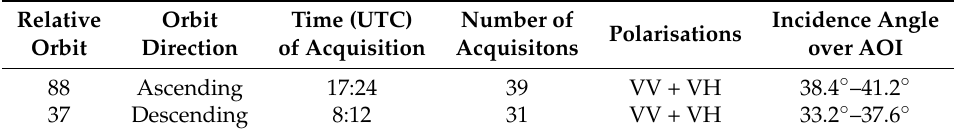
Table 1. Metadata of the Sentinel-1, A and B, acquisitions used in this study, VV = vertically transmitted vertically received, VH = vertically transmitted horizontally received.